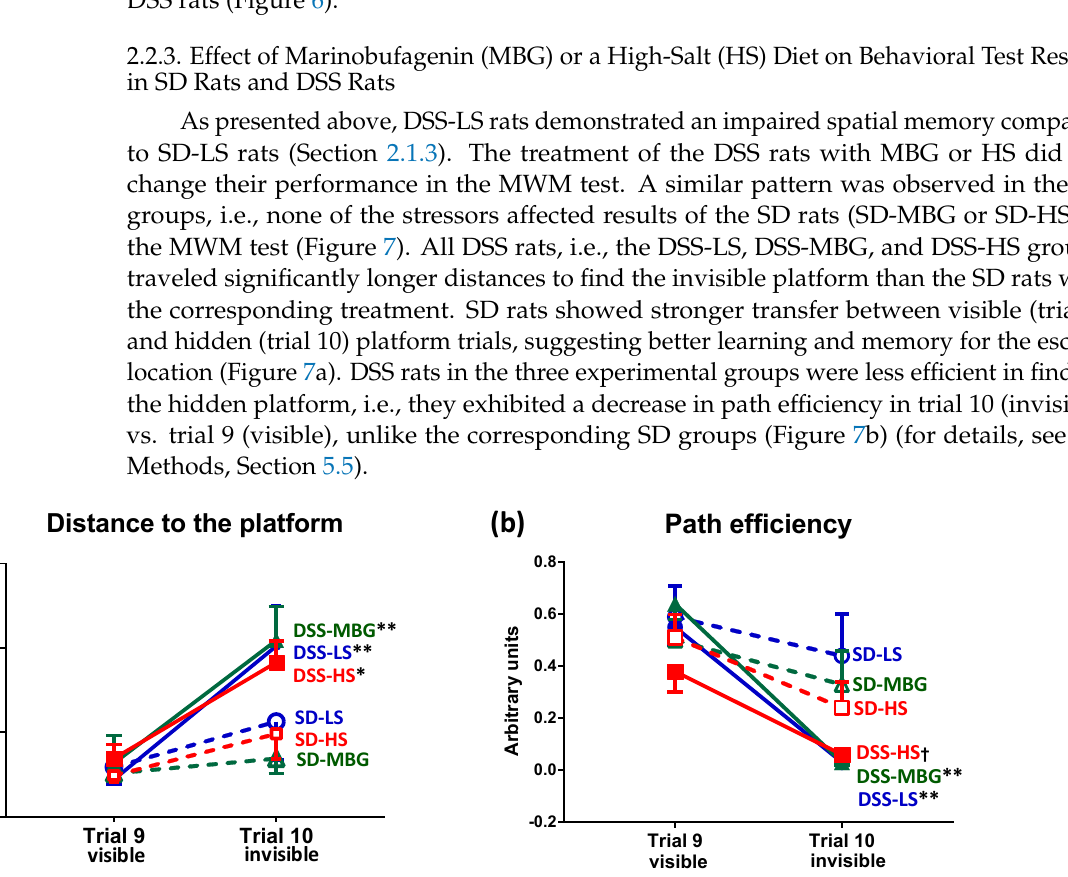
Figure 7. Morris water maze (MWM) test results. ( a ) Distance to the platform in MWM test. ( b ) Path efficiency in MWM test. MWM test was performed in four-month-old Sprague-Dawley (SD) rats and four-month-old Dahl salt-sensitive (DSS) rats which received low-salt (LS) diet (SD, n = 8; DSS, n = 7), MBG (SD, n = 8; DSS, n = 7) and high-salt (HS) diet (SD, n = 7; DSS, n = 8). Values are expressed as mean ± SEM. Two-way ANOVA followed by Tukey’s post hoc test: * p < 0.05, ** p < 0.01, for trial 9 vs. trial 10 in the corresponding group. Two-tailed t -test: † p < 0.05 for trial 9 vs. trial 10 in DSS-HS. Dotted lines, SD groups; solid lines, DSS groups; blue, LS; green, MBG; red, HS. The density of neurons in the hippocampus was estimated in all the studied groups.